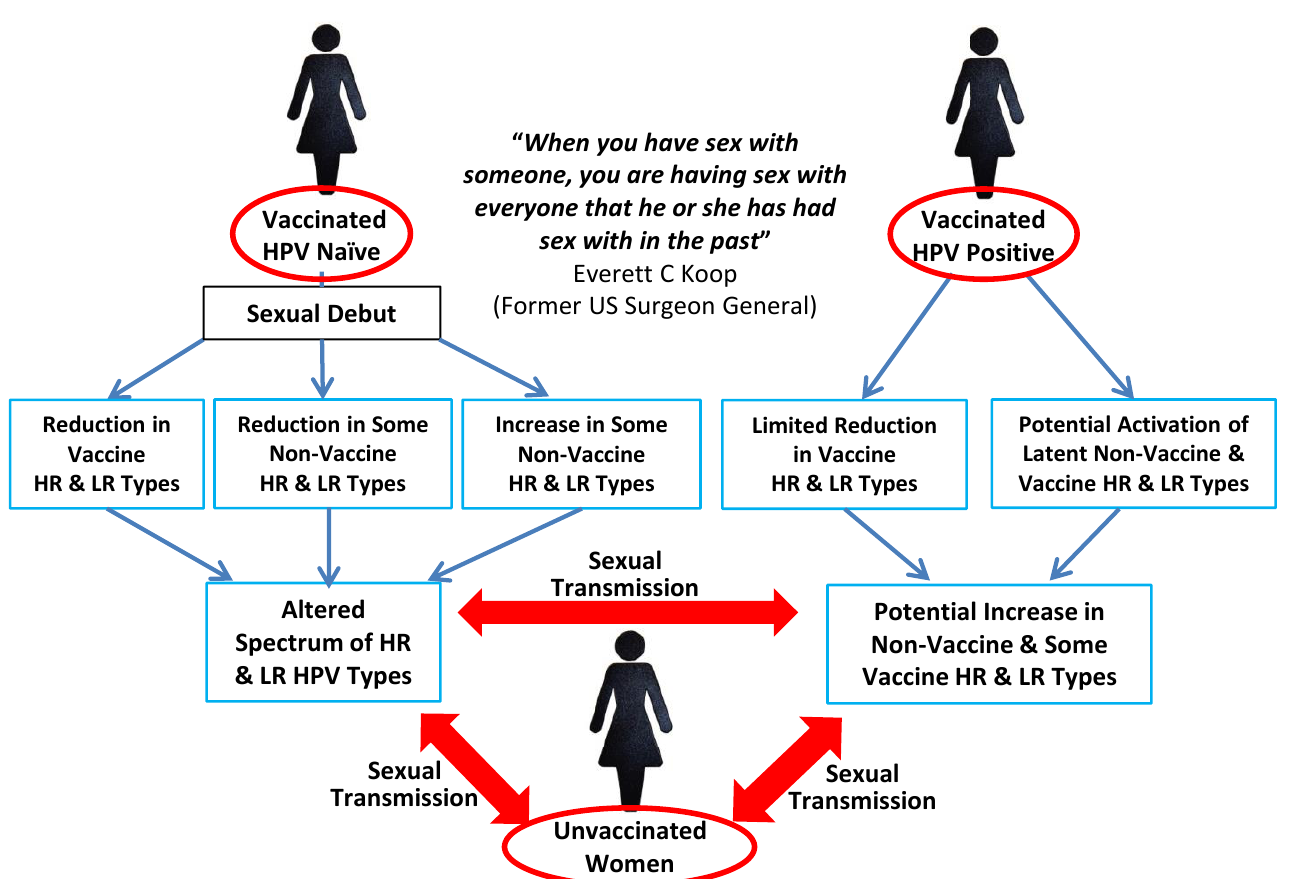
Figure 9. Potential for dissemination of vaccine-related changes in HPV types between vaccinated and unvaccinated women. Illustrates how vaccine-induced changes in the prevalence of different HPV types in vaccinated women could be disseminated to unvaccinated women via partner-mediated sexual transmission.